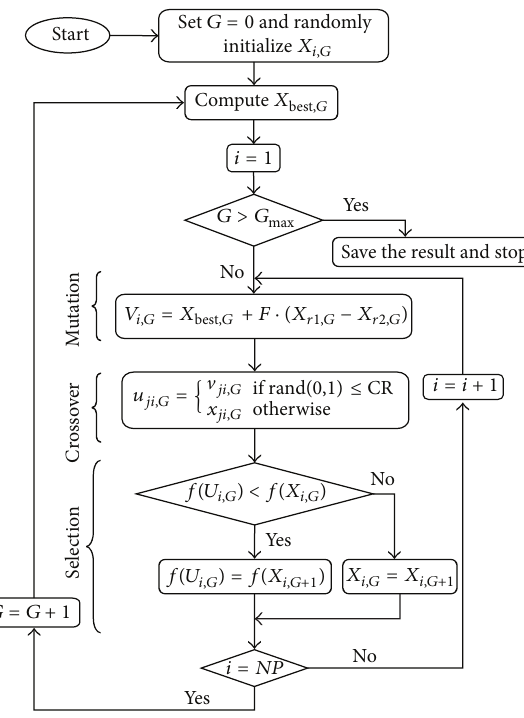
Figure 3: Flow chart of Differential Evolution (DE)